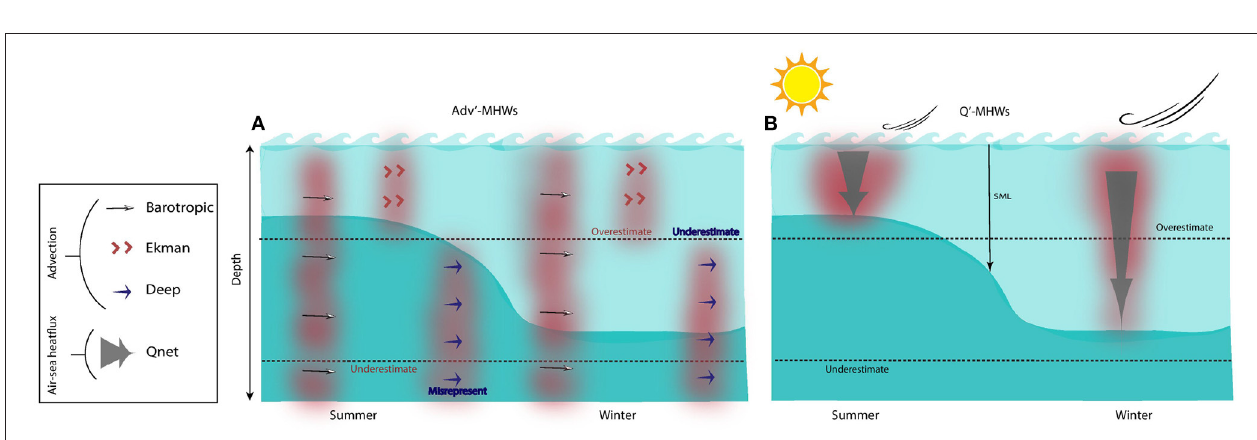
FIGURE 13 | Schematic illustrating the relationship between MHW drivers in a varying SML depth and two examples of fixed depths. Adv’-MHWs and Q’-MHWs (marked by the red shading) are shown in Panels (A,B) , respectively. The cases in which a fixed depth may result in an underestimation, overestimation or misrepresentation of the driver contribution are marked with